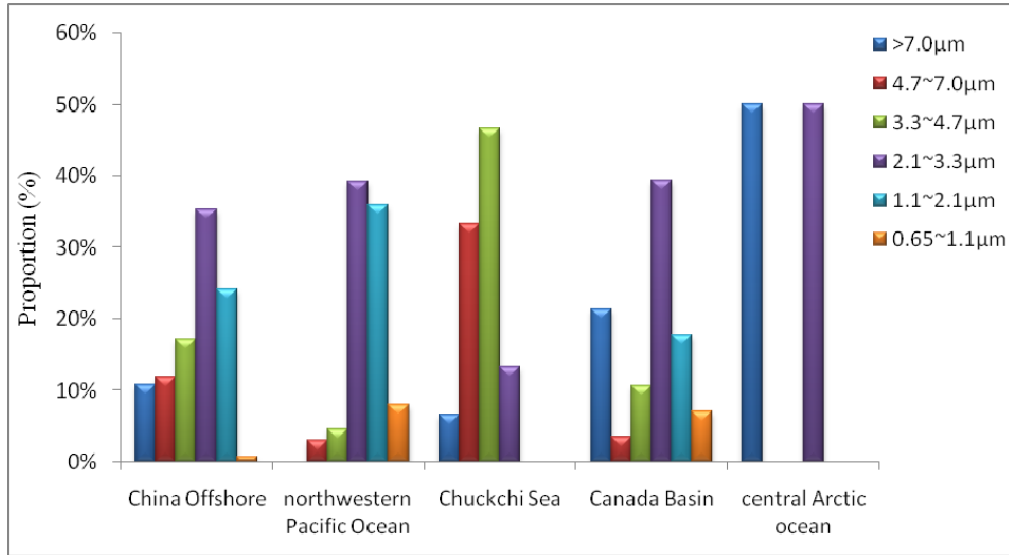
Figure 3. Size distributions of airborne fungi in different